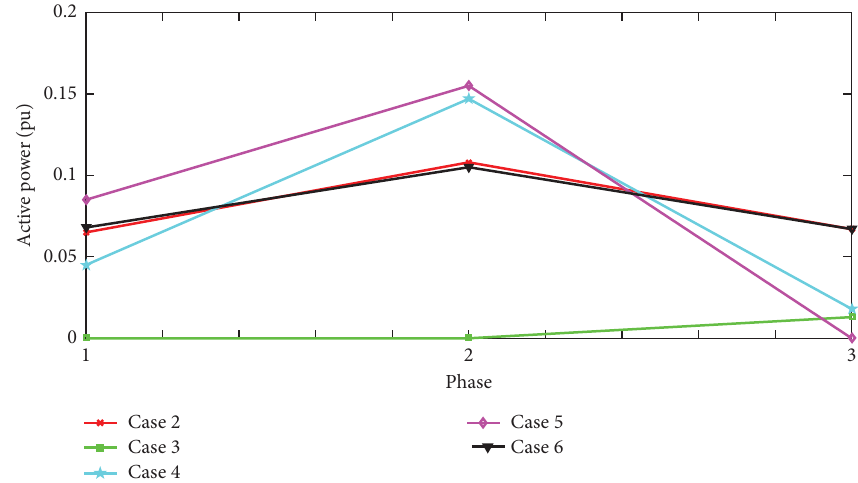
Figure 6: Active power generation of each phase of the wind system in diferent case studies.